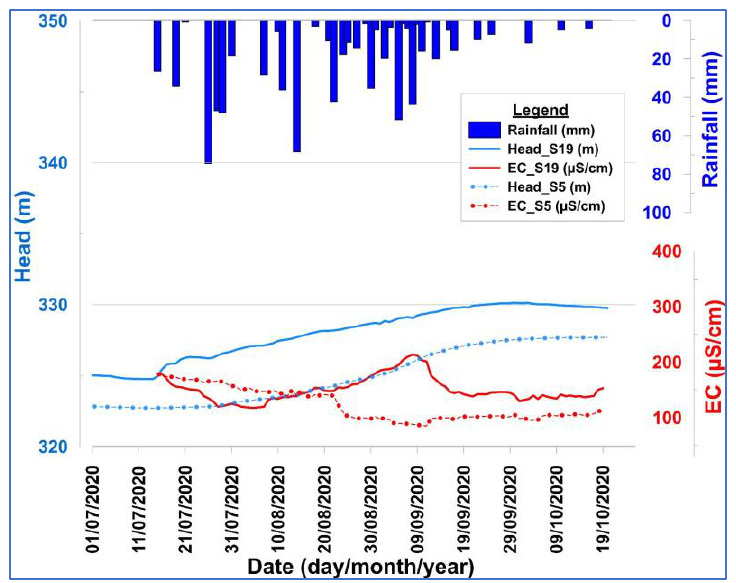
Figure 16. Groundwater hydrographs versus electrical conductivity in relation to rainfall at the outlet of the catchment.